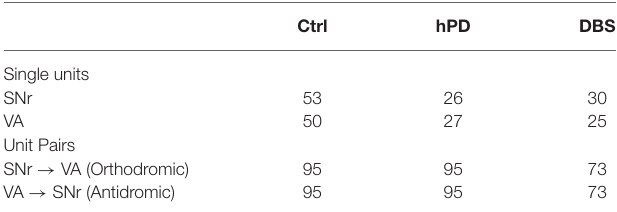
TABLE 1 | Number of neuronal units and pairs . Ctrl hPD